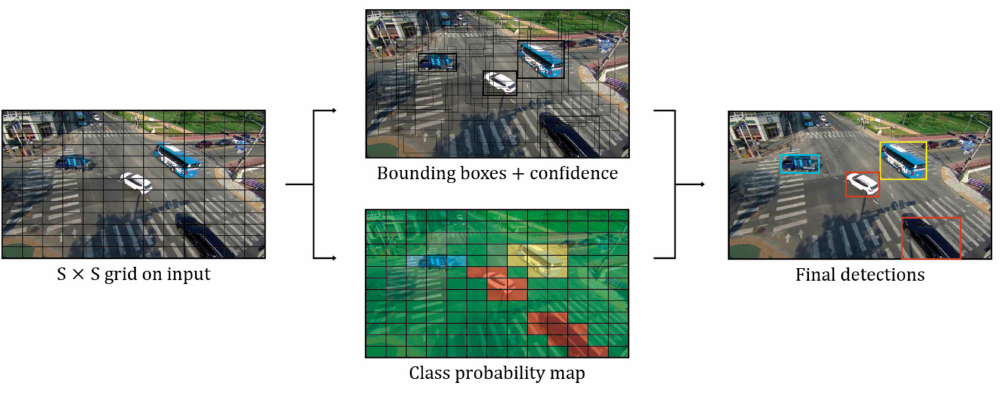
Figure 5. The framework of YOLO on our